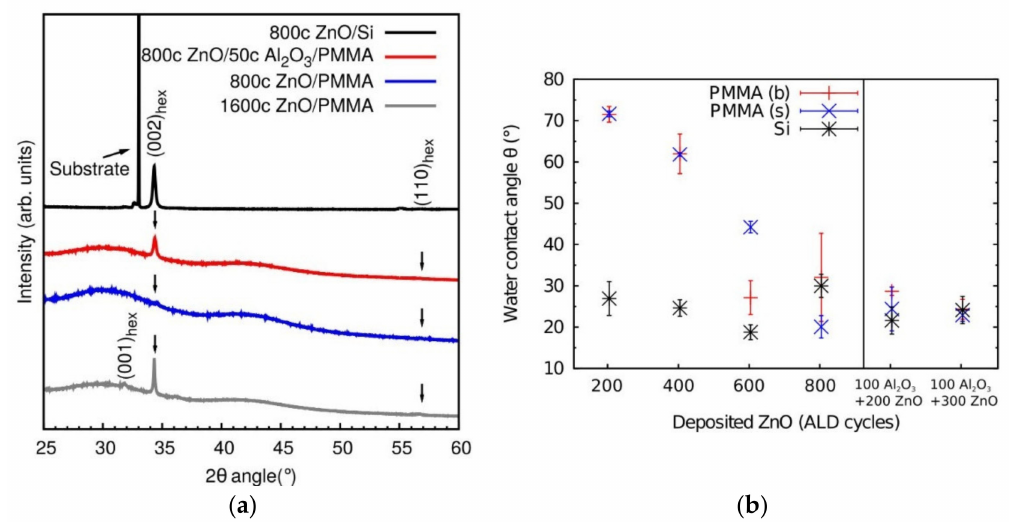
Figure 16. XRD patterns for 800 cycles of ZnO ALD onto: Si (black) and bulk PMMA substrates with (red) and without Al 2 O 3 seed layer (blue), and an XRD pattern of 1600 cycles ZnO film on bulk PMMA(grey). ( a ) Water contact angles ( θ ) of UV-illuminated ZnO deposited on bulk PMMA (red), spin-coated PMMA (blue), and Si substrates as a function of ZnO ALD cycles (black). The two right-most points represent the contact angles of ZnO deposited on 100 cycles Al 2 O 3 intermediate layer ( b ) (reprinted with permission from [67], Copyright (2014), American Vacuum